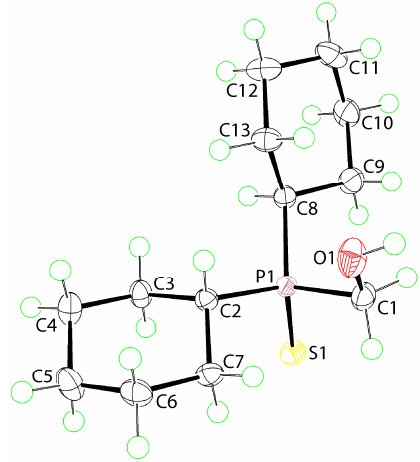
Figure 2. The molecular structure of Compound 1 showing atom labelling and displacement ellipsoids at the 70% probability level. Selected geometric parameters: P1-S1 = 1.9784(4) Å, P1-C1 = 1.8308(12) Å, P1-C2 = 1.8257(12) Å, P1-C8 = 1.8315(12) Å, S1-P1-C1 = 110.06(4)°, S1-P1-C2 = 112.65(4)°, S1-P1-C8 = 112.49(4)°, C1-P1-C2 = 104.72(6)°, C1-P1-C8 = 108.63(6)°, C2-P1-C8 = 107.93(6)°.